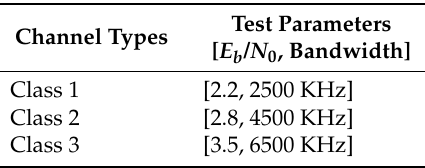
Table 5. Test channel parameter.